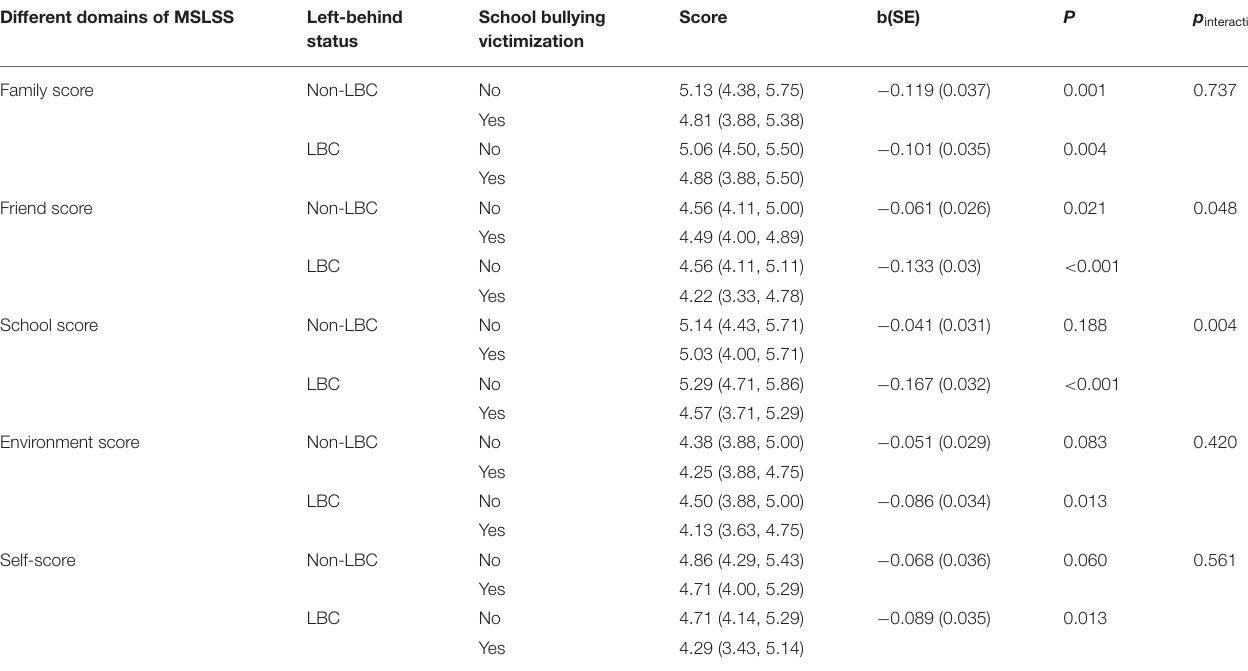
TABLE 3 | Interaction effect of left-behind status and bullying victimization on different domains of life satisfaction. Different domains of